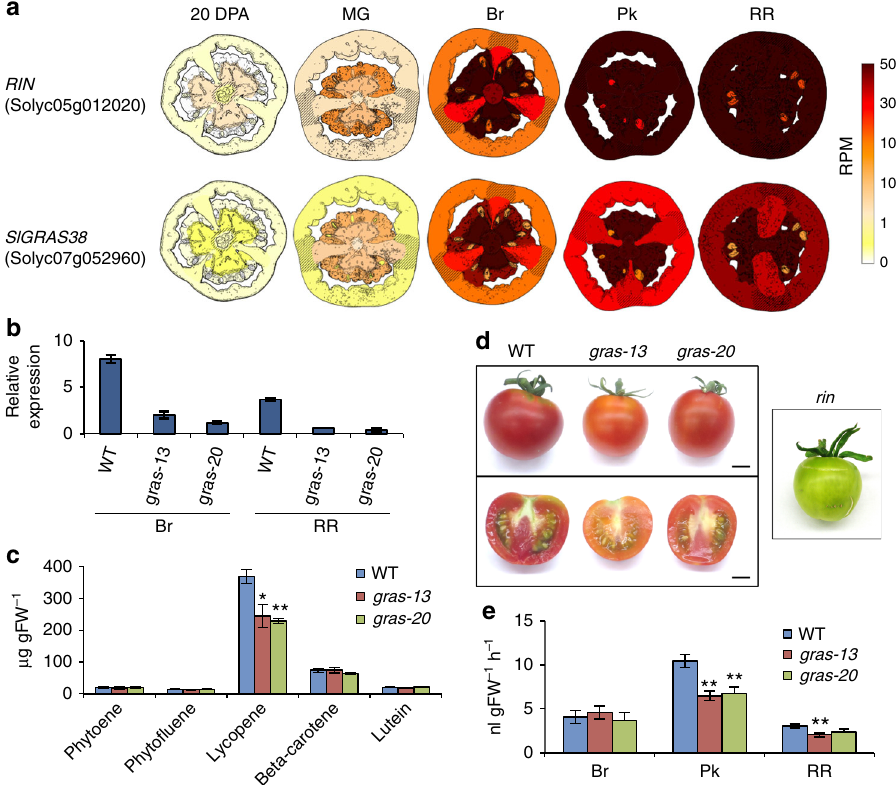
Fig. 5 The role of SlGRAS38 in fruit ripening regulation. a Tissue-based expression images of two M6 hub TF genes, RIN and SlGRAS38 (Solyc07g052960). b Expression of SlGRAS38 in Br and RR transgenic fruit from two independent SlGRAS38 -RNAi lines and WT normalized to RPL2 . c Carotenoid levels of RR fruit at 7 days after Br from SlGRAS38 -RNAi lines and WT. d Representative fruit of WT, SlGRAS38- RNAi, and rin mutant plants. Fruit of WT and SlGRAS38- RNAi lines at 4 days after Br and that of rin at a stage corresponding to RR in WT are shown. Scale bars are 1 cm. e Ethylene production in SlGRAS38 -RNAi and control fruit. Values are mean ± s.e.m. ( n = 3 in b , c , and 7 in e ). Asterisks in c , e indicate signi fi cant differences between WT and each SlGRAS38